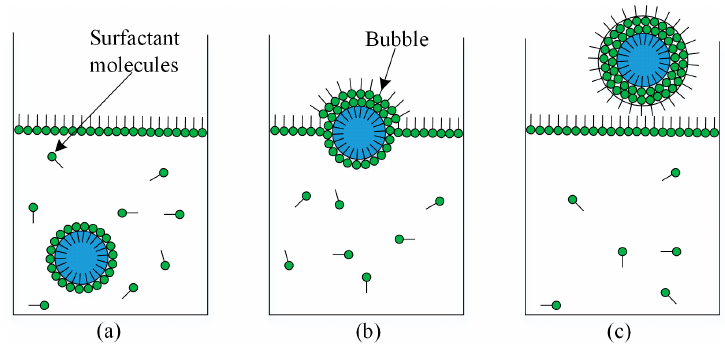
Figure 3. Foam formation process: ( a ) bubble formation, ( b ) adhesion and rise, and ( c ) foam formation.